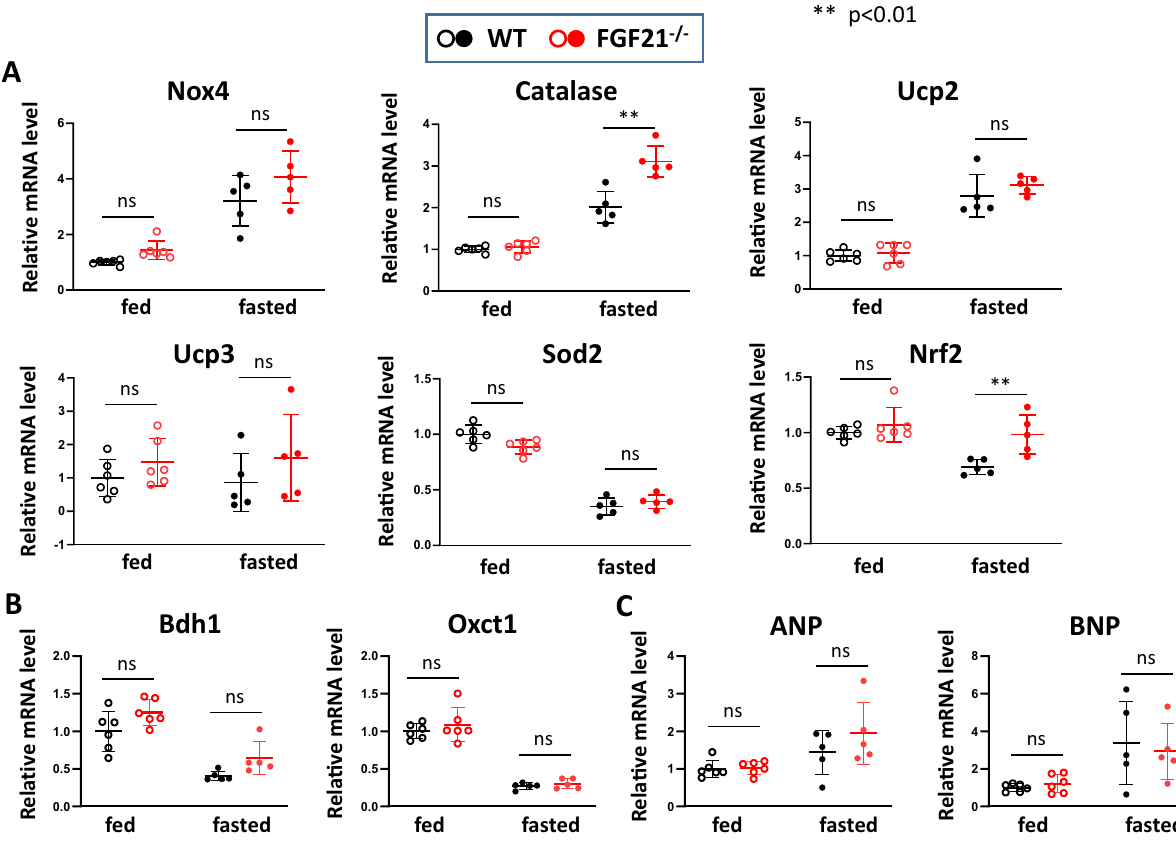
Figure 5. Effects of fasting on the oxidative stress response gene expression in Fgf21 −/− mice hearts. qPCR was performed to measure the mRNAs levels for oxidative stress response genes ( A ) and ketolytic enzymes and hypertrophic marker genes ( B ) in WT and Fgf21 −/− mice hearts under either fed or 24 h-fasted conditions. Data are mean ± SD (n = 5–6). **p < 0.01 vs corresponding control (WT) analyzed by one-way ANOVA followed by Tukey correction for multiple